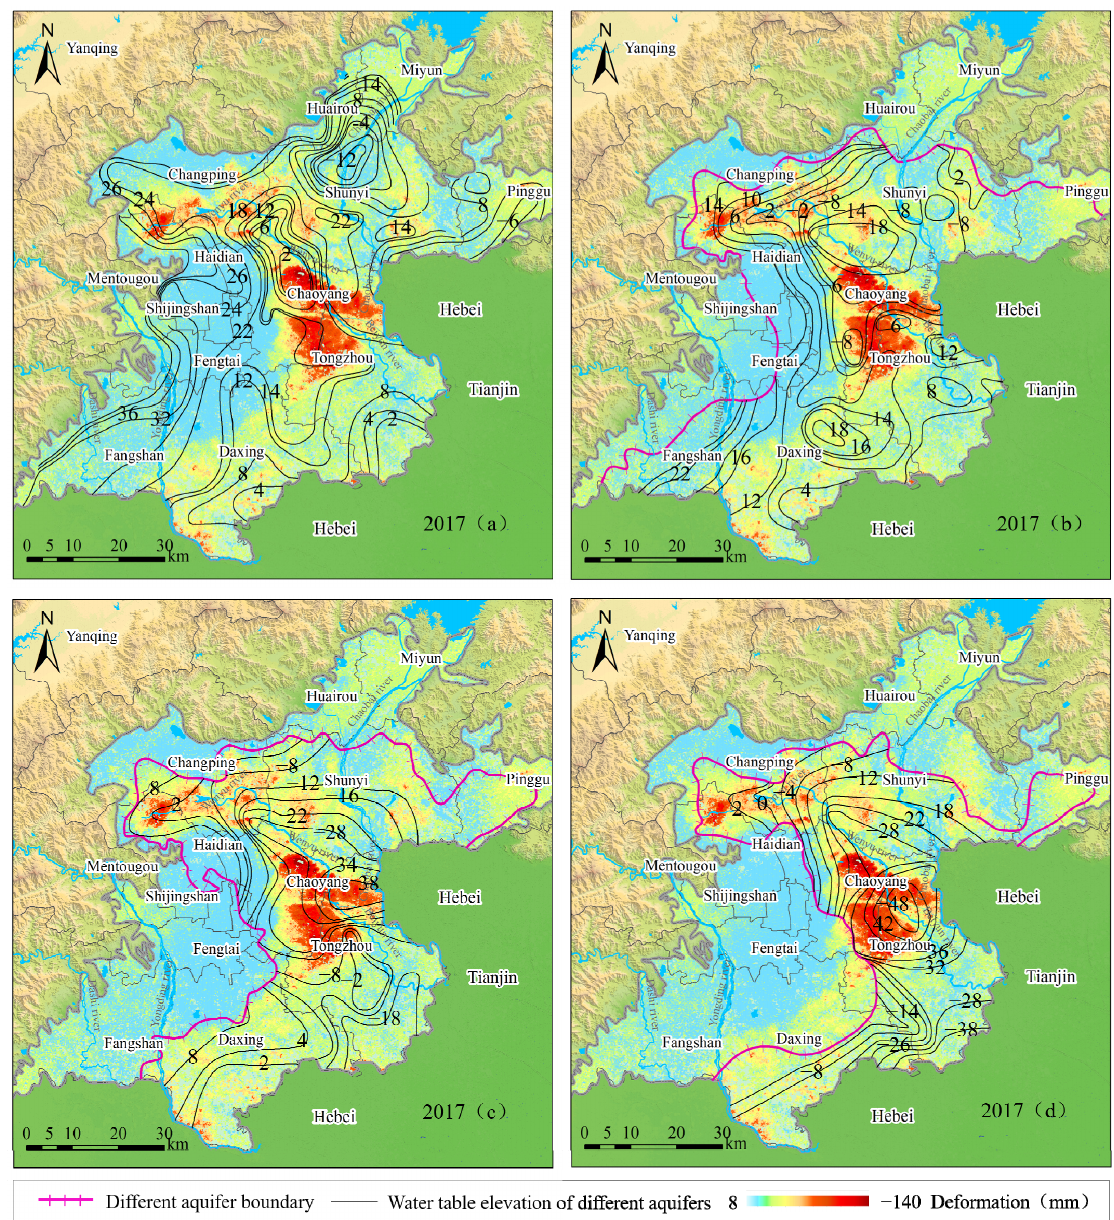
Figure 13. Land subsidence and water table elevation of different aquifers (2017). ( a ) Unconfined aquifer. ( b ) First confined aquifer. ( c ) Second confined aquifer. ( d ) Third confined aquifer.